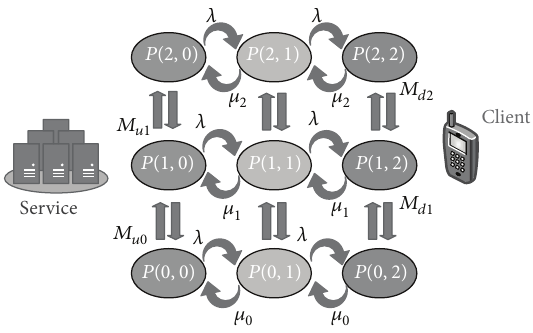
Figure 2: Multidimension model for evaluating application perfor- mance over a series of